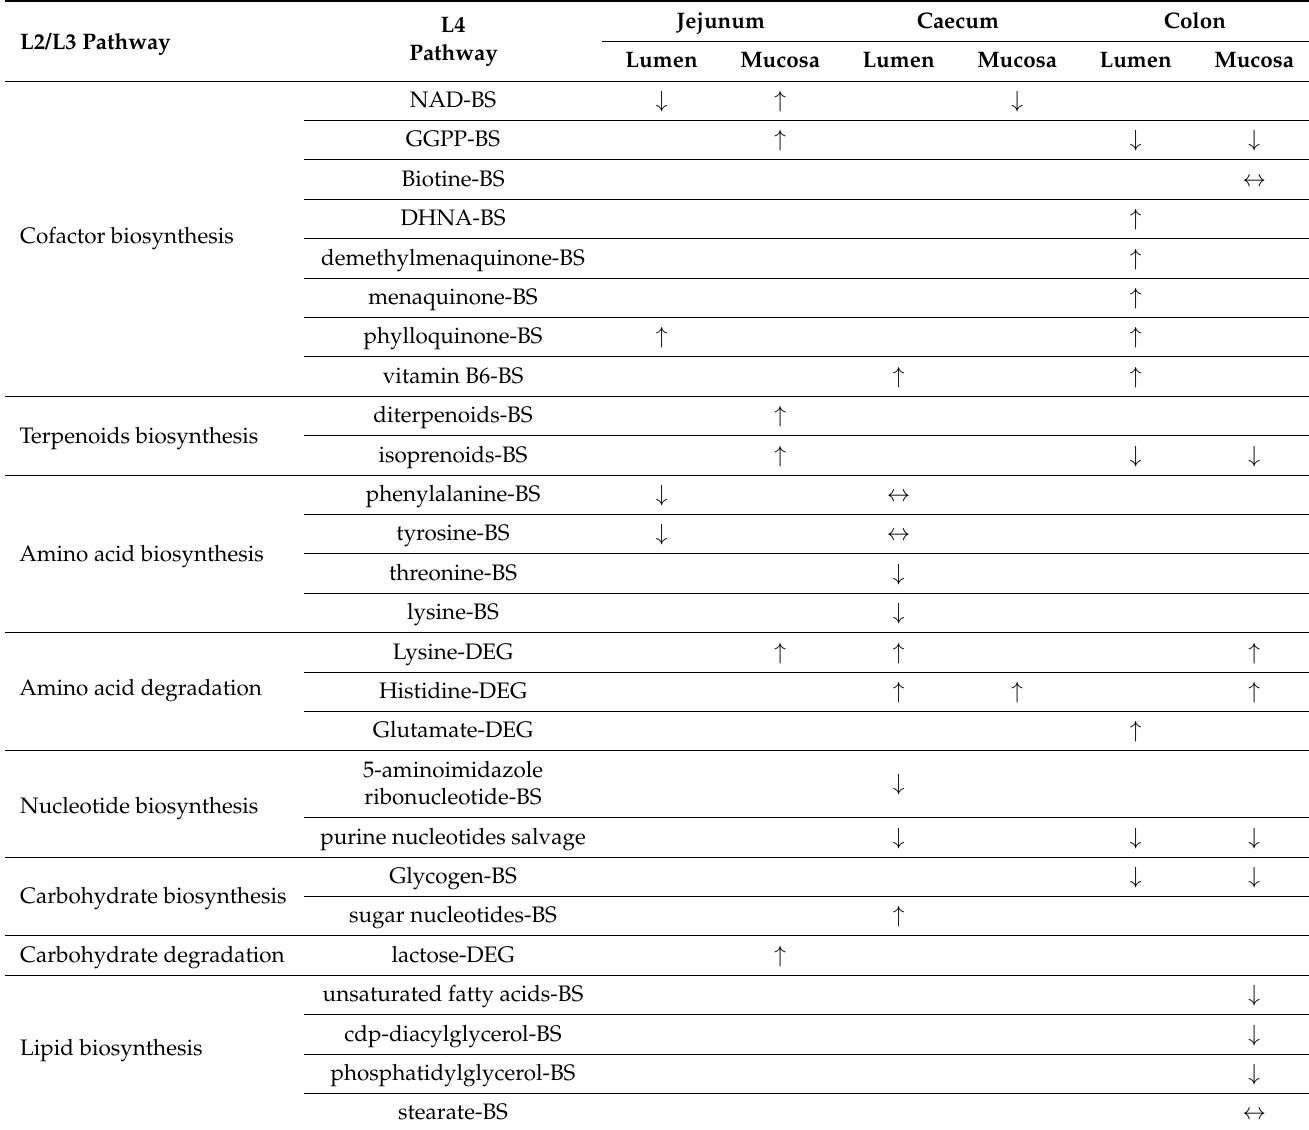
Table 2. Table of level-4 MetaCyc pathways found as differentially abundant ( p < 0.05) in samples from rabbits fed a BC-supplemented diet, separated on intestinal tracts and sampling sites. For each level-4 pathway, the corresponding upper lineage classification is reported. “BS”: “biosynthesis”; “DEG”: “Degradation”. The arrow direction indicates whether the pathway was enriched (more abundant) or depleted (less abundant) in BC-supplemented samples (both for 2.5% BC and 5% BC). ↔ indicates that there was a contrasting behaviour for 2.5% BC and 5% BC samples with respect to the CTRL